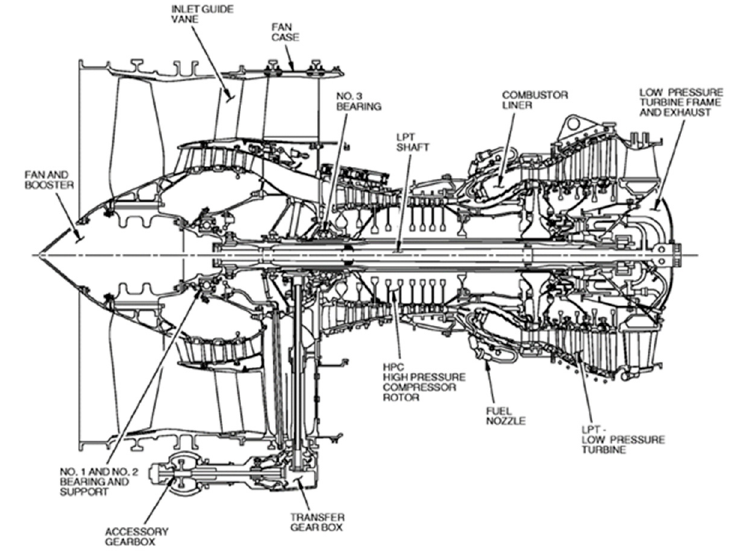
Figure 3. CFM56 drawing [33].